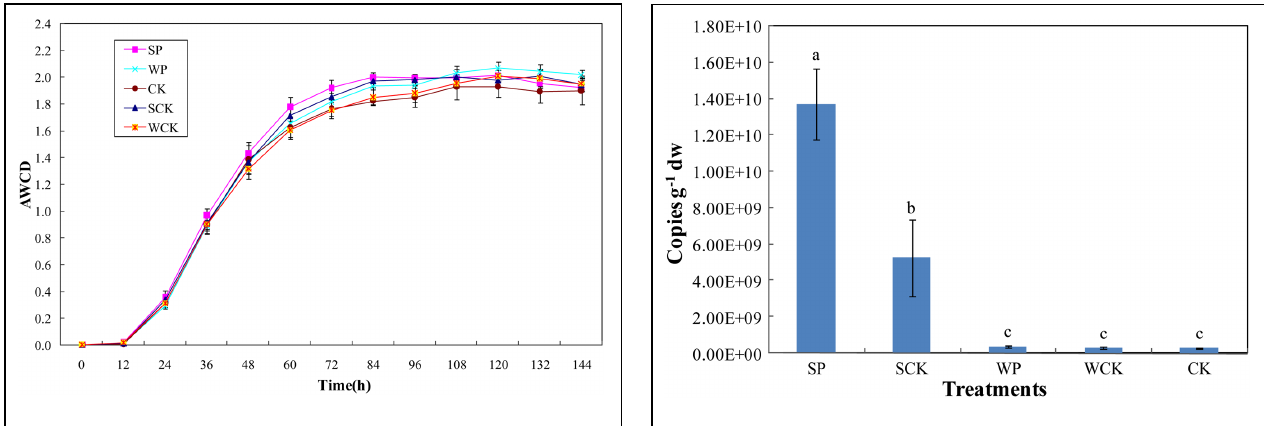
FIGURE 5 | Average well color development (AWCD) values of microbial communities under the different treatments. Values are means ± SD of triplicate measurements.